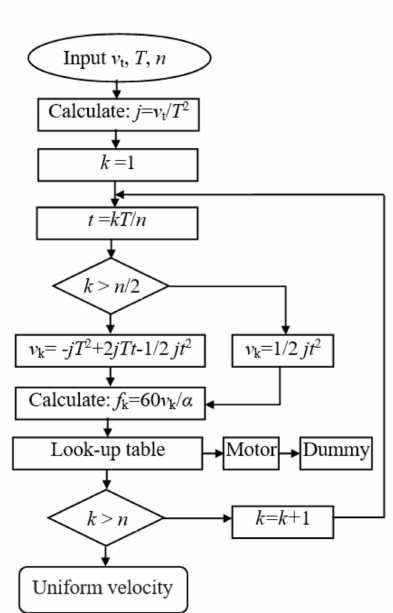
Figure 10. The flow chart of the program of increasing velocity stage in the S-shaped velocity curve. Initial and final velocities of the dummy target are zero. According to kinematics principles, the expressions of acceleration a ( t ), velocity v ( t ), and displacement S ( t ) of the dummy target in each stage are shown in Table